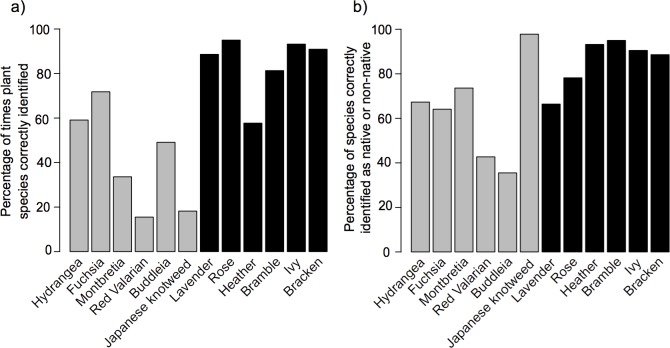
Results of plant identification survey for a) percentage of times each plant was correctly identified; b) percentage of times each plant was correctly classified as native or non-native. Light grey bars = non-native species; black bars = native species.